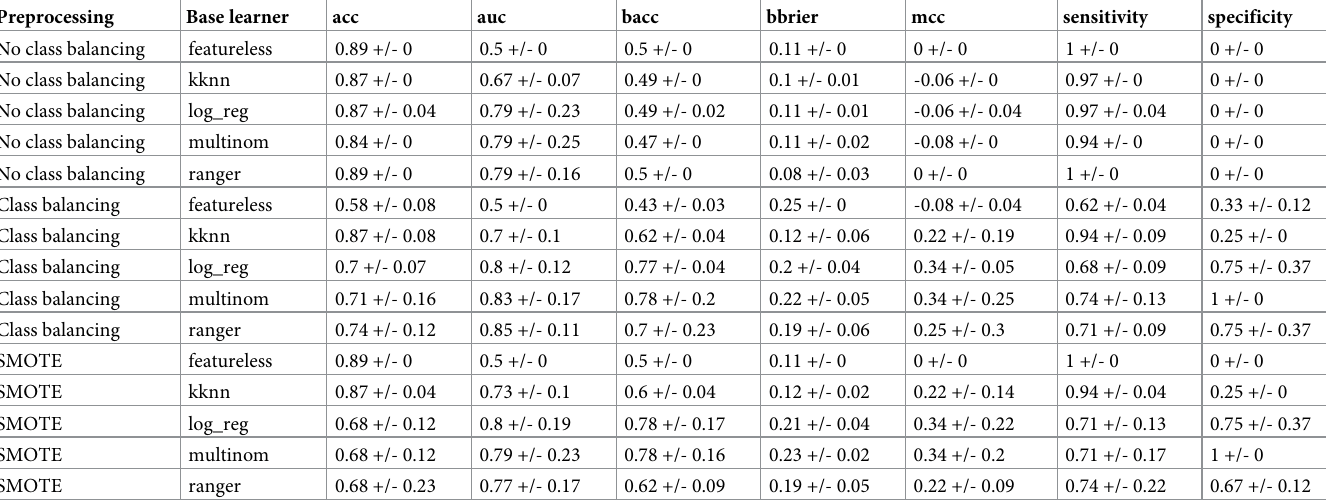
Table 3. Comparison of different class balancing approaches on model performance with 5-fold cross-validation on training